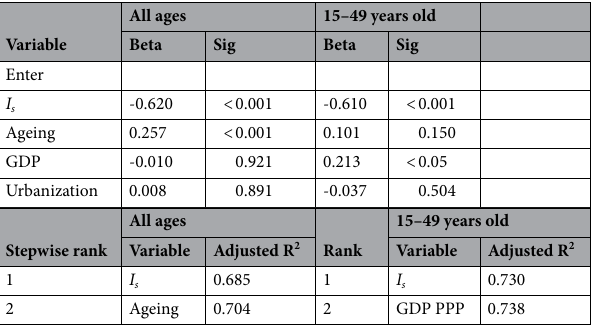
Table 3. Multiple linear regression analyses to examine predictors of dementia incidence. Significance level: p < 0.05, p < 0.01, p < 0.001. Data sources: Dementia Incidence expressed as the number of new onsets of Alzheimer’s disease and other dementias published by the Institute for Health Metrics and Evaluation (IHME) in 2020; I s measuring the magnitude of the opportunity for natural selection, extracted from the previous publication by You et al. https:// doi. org/ 10. 1111/ eva. 12523; Ageing expressed with life expectancy at 65 years old (2010–2015) published by the United Nations; GDP PPP expressed in purchasing power parity in 2015 US dollars published by the World Bank; Urbanization expressed in percent of population living in urban areas in 2015 published by the World Bank.